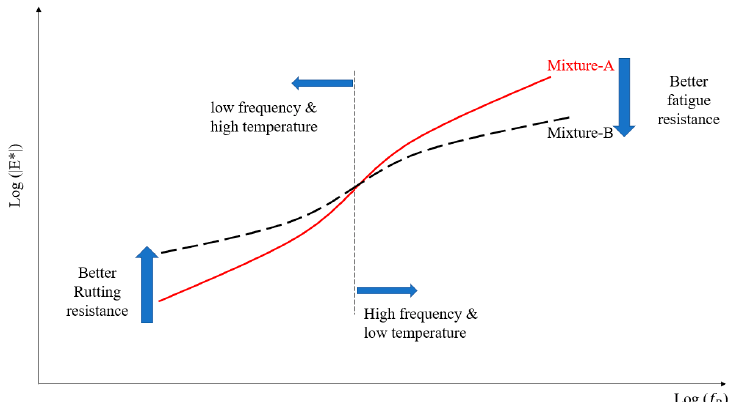
Figure 4. Demonstration of the dynamic modulus master curve.